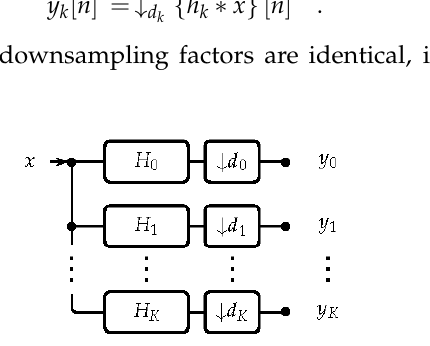
Figure 1. General structure of a non-uniform analysis filter bank (FB) ( H k , d k ) k with H k being the z -transform of the impulse response h k [ n ] of the filter, also denoted as A ( · , ( H k , d k ) k )